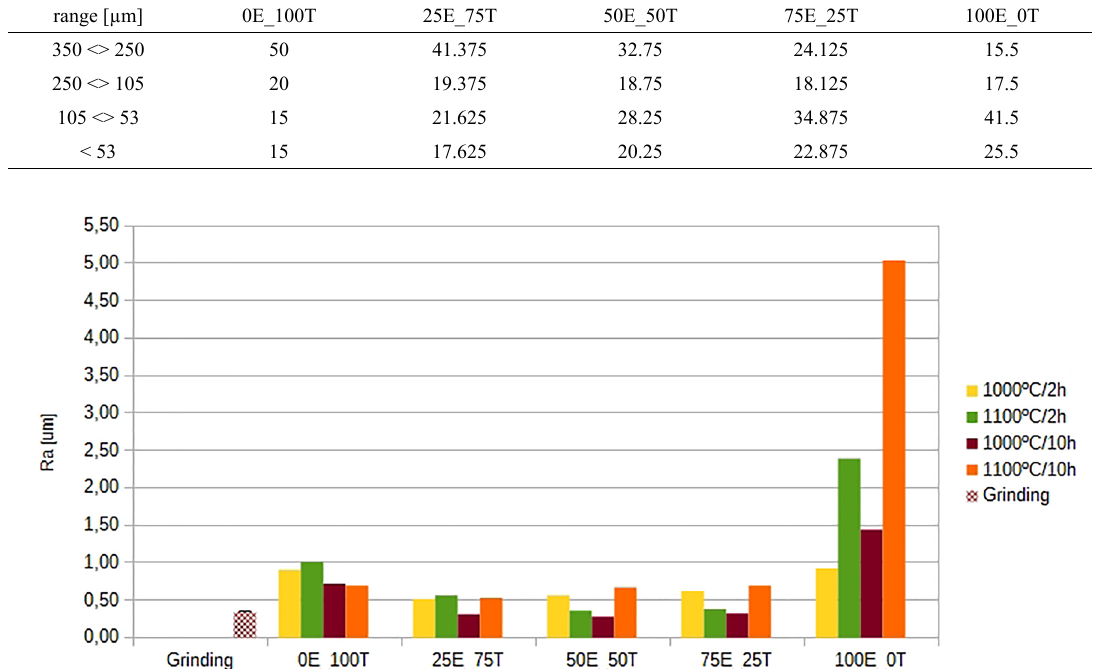
Table 1. Granulometry distribution of the powders' mixtures (% w).